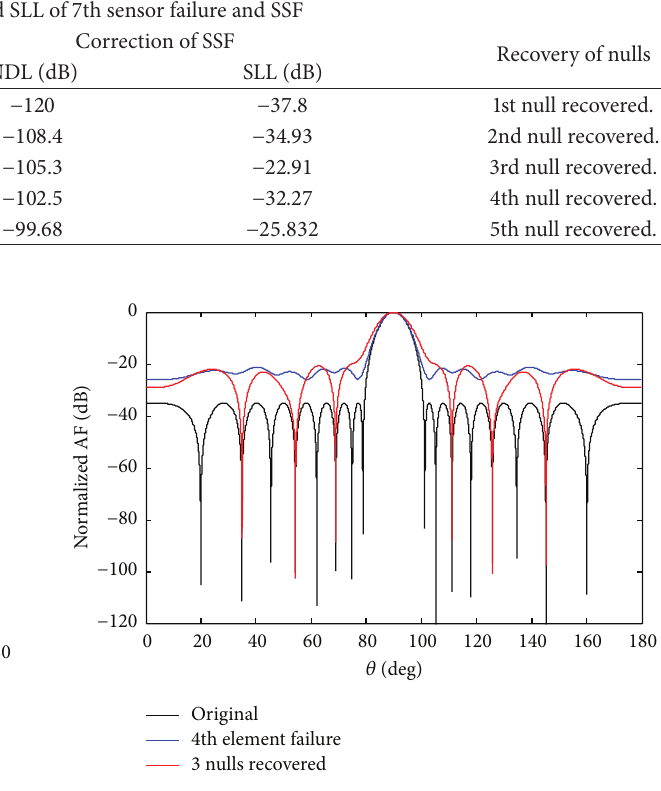
Figure 12: The original radiation pattern, the 𝑤 4 sensor failure, and recovery of three